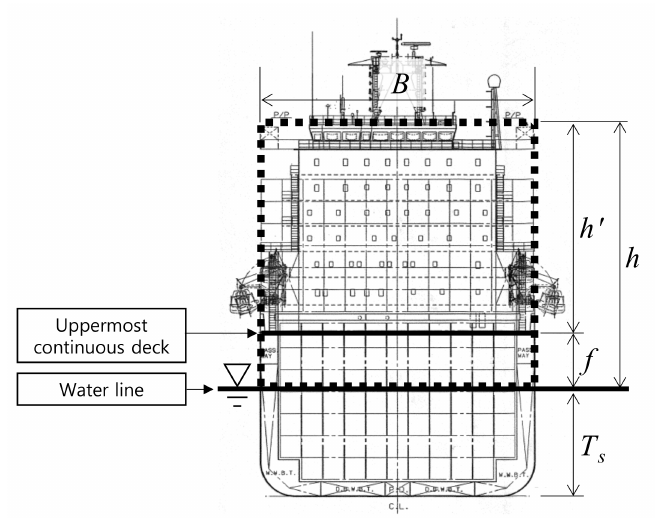
Figure 2. Variables of the second term of the equipment number formula.